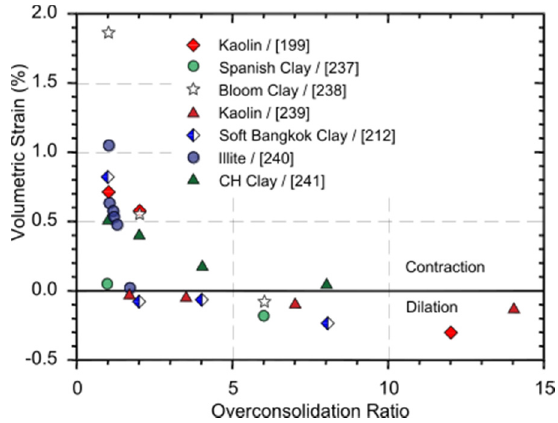
Figure 25. Evolution of volumetric strain with the over-consolidation ratio (OCR) for clays ( ∆ T = 20–40 °C) (adapted from Reference [26] using data from References [203,216–221]).